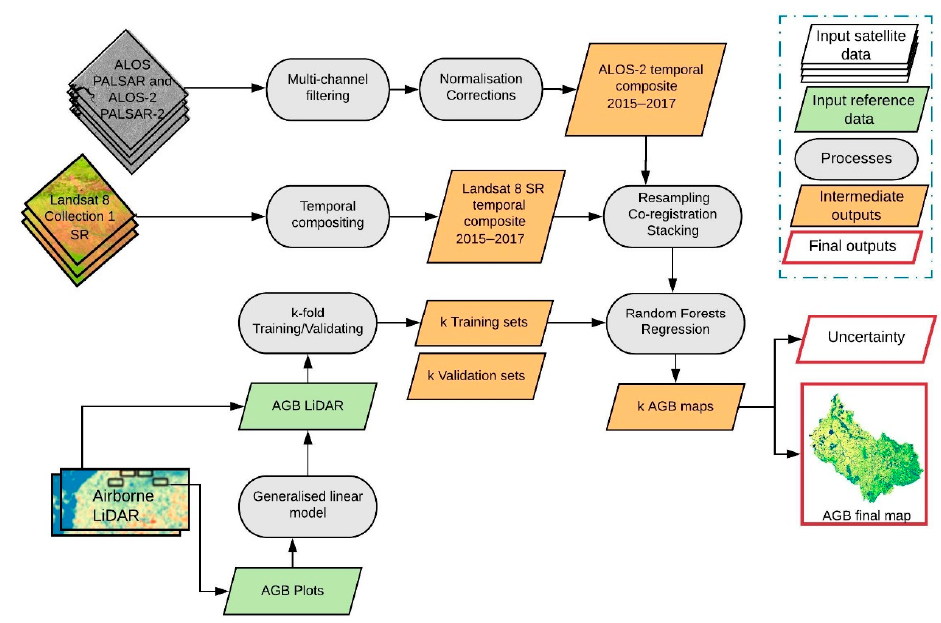
Figure 2. Flowchart showing the methodology used to produce the aboveground biomass (AGB) map of the Rio Vermelho watershed, Goiás State, Brazil. SR = surface